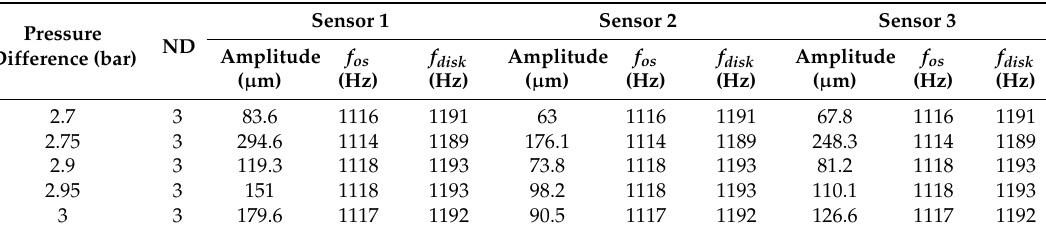
Table 7. Results for the second prototype at RPM nominal .